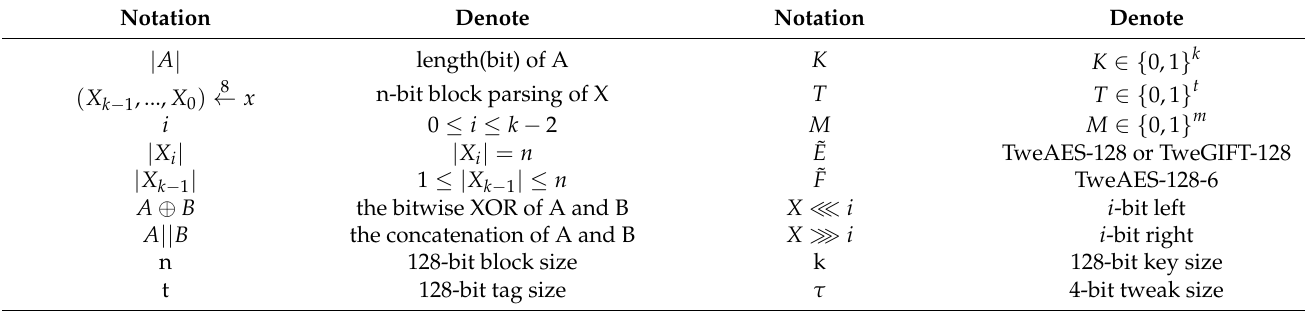
Table 2. Energy efficient and Single-state Tweakable block cipher-based MAC-Then-Encrypt (ESTATE) notation [16].